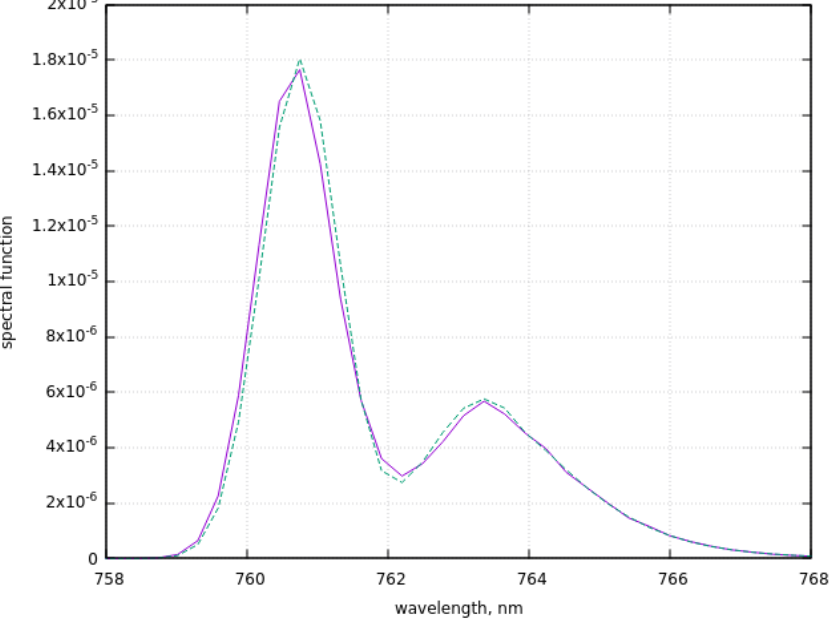
Figure 5. The spectral function tabulated in [30]) (solid line) and derived using Equations (63) and (64) (dashed line).